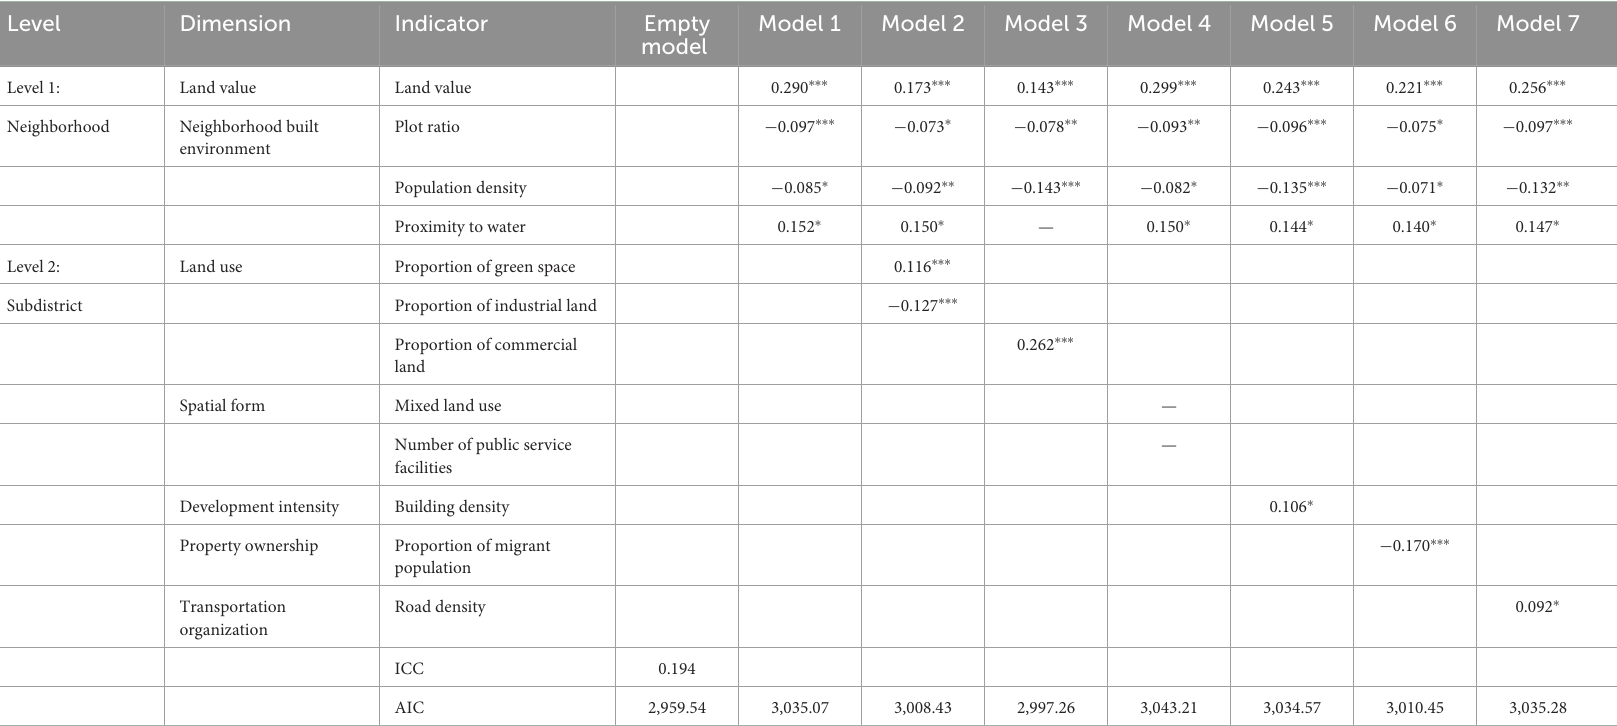
TABLE 4 Two-level regression results for neighborhoods and